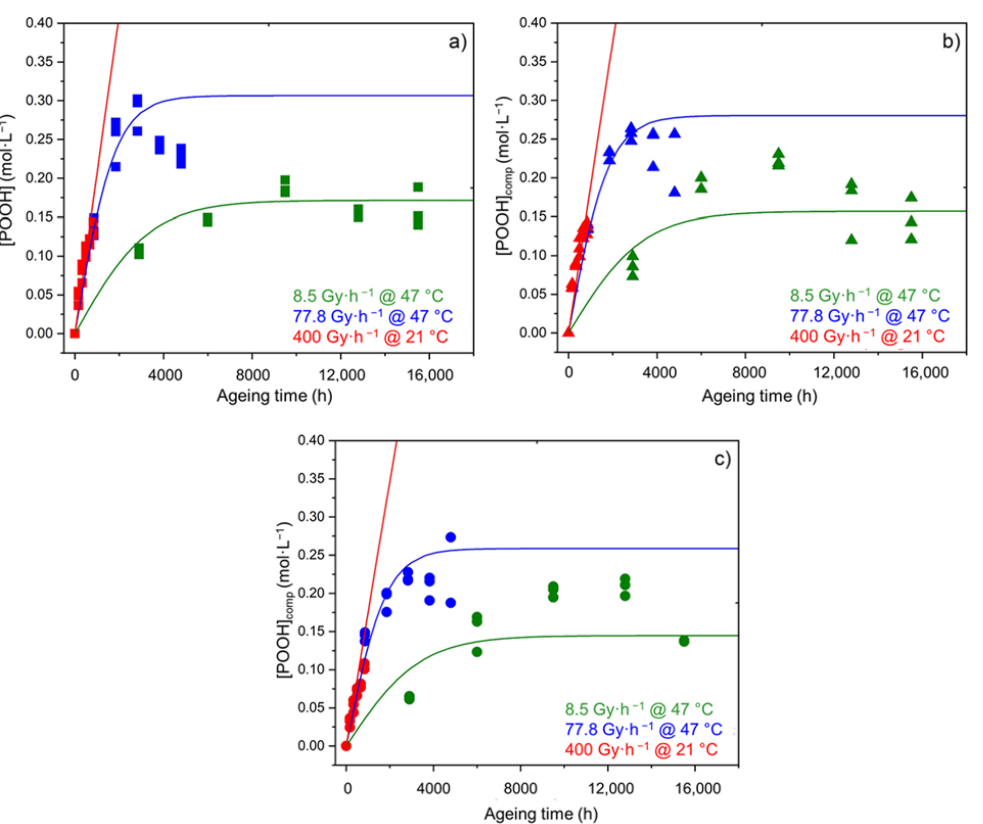
Figure 17. Kinetic modeling of the changes in the hydroperoxide concentration in the unfilled Si ‐ XLPE matrix ( a ) and the two composite materials with 25 phr ( b ) and 50 phr ( c ) of ATH, during their radio ‐ thermal exposure in air under 8.5 Gy ∙ h − 1 at 47 °C (green), under 77.8 Gy ∙ h − 1 at 47 °C (blue), and under 400 Gy ∙ h − 1 at 21 °C (red).